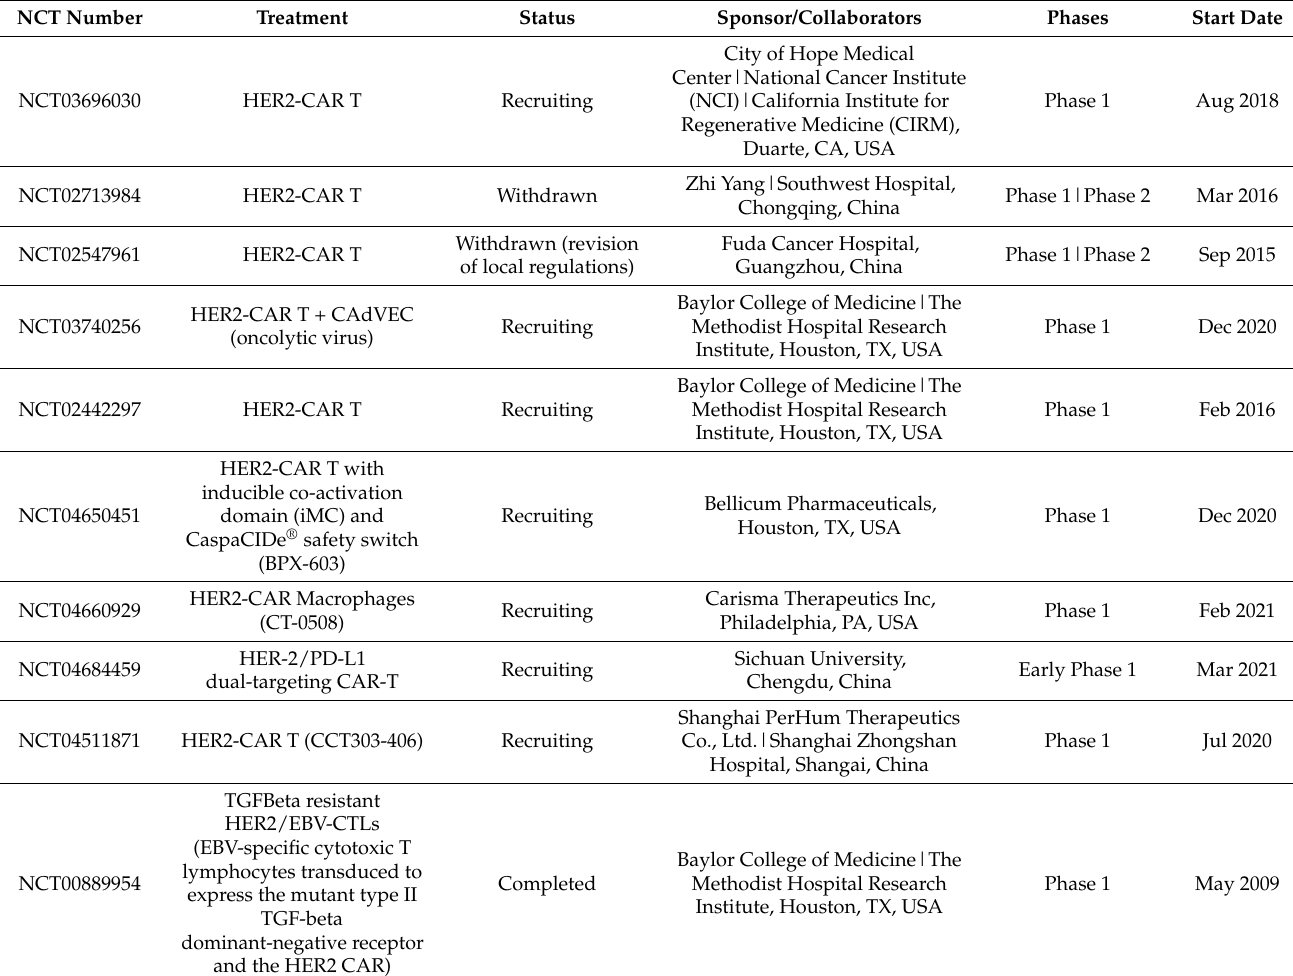
Table 2. HER2 CAR therapies in clinical trials for the treatment of HER2-positive tumors, including breast tumors and derived